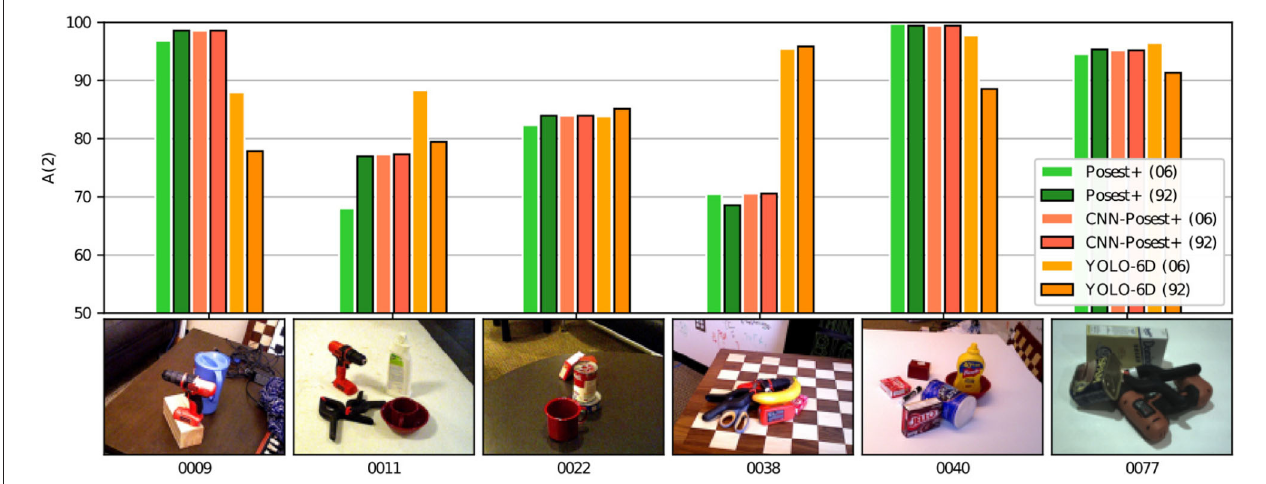
FIGURE 6 | Per-class accuracy A (2) on two YCB92 sub-datasets: For the 20% training ratio we compare the 6 and the 92 class cases. On the x-axis the 6 common objects are shown together with their YCB-Video sequence